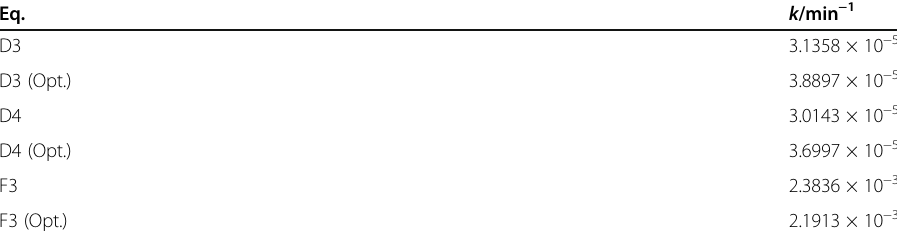
Table 2 The values of average k obtained from equations D3, D4, and F3 and the corresponding optimized values for reaction of MgO with charcoal in molar ratio 1:1 and at temperature 1723.15 K Eq. k /min − 1